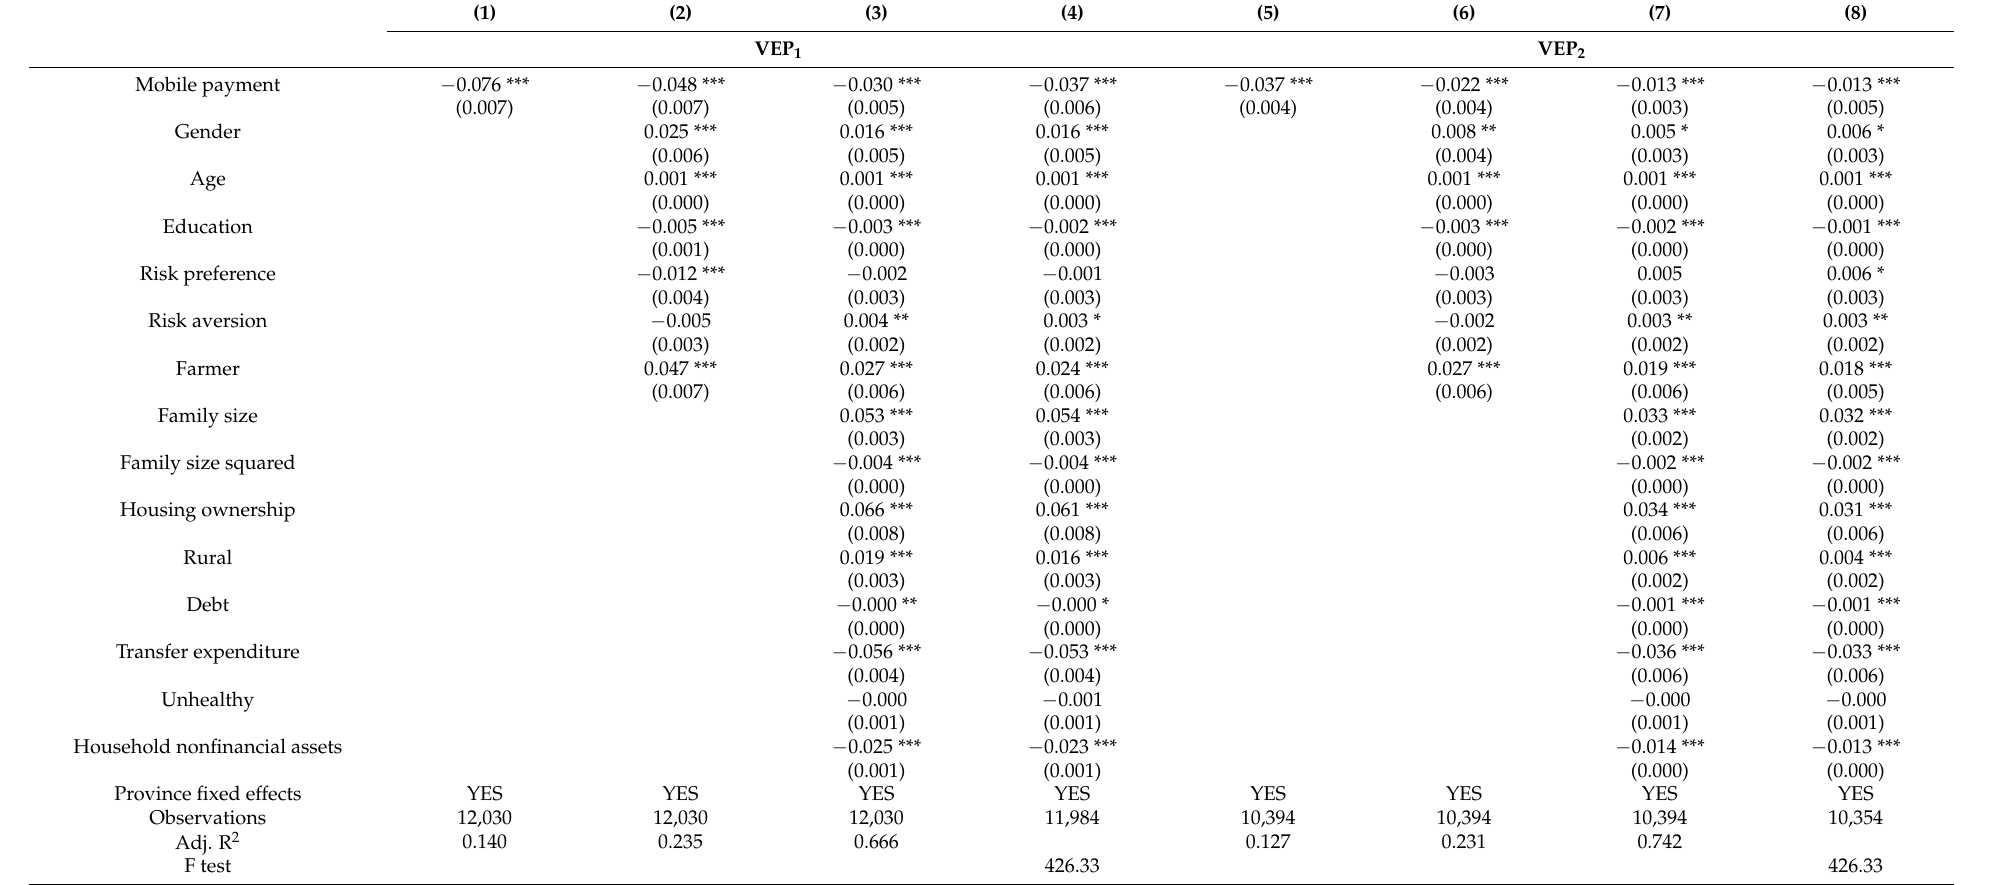
Table 4. Impact of mobile payment on household poverty vulnerability: the probit and 2SRI